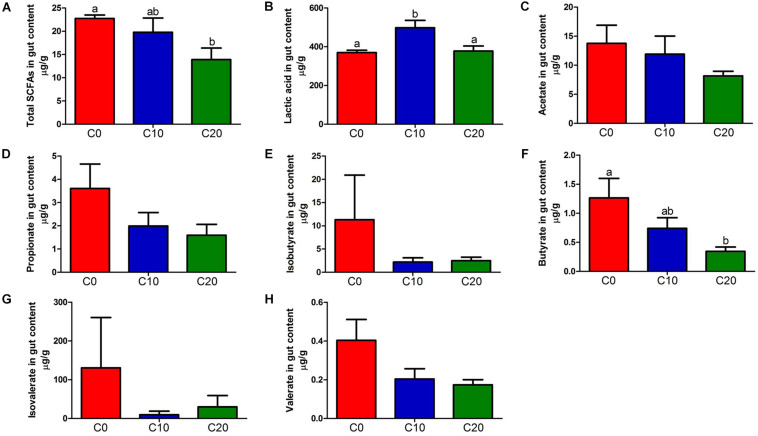
Short-chain fatty acid (SCFA) concentrations (μg/g) and Lactic acid (LAc) concentrations (μg/g) in the hindgut content of fish in the three treatments. (A) Total SCFAs concentrations (μg/g); (B) Lactic acid (LAc) concentrations (μg/g); (C) Acetate concentrations (μg/g); (D) Propionate concentrations (μg/g); (E) Isobutyrate concentrations (μg/g); (F) Butyrate concentrations (μg/g); (G) Isovalerate concentrations (μg/g); (H) Valerate concentrations (μg/g). C0, non-challenge control; C10, 10% gelatinized starch-challenged group; C20, 20% gelatinized starch-challenged group. Data are presented as the means ± SEMs (n = 3). Different lowercase letters above the bars indicate significant difference (P < 0.05).